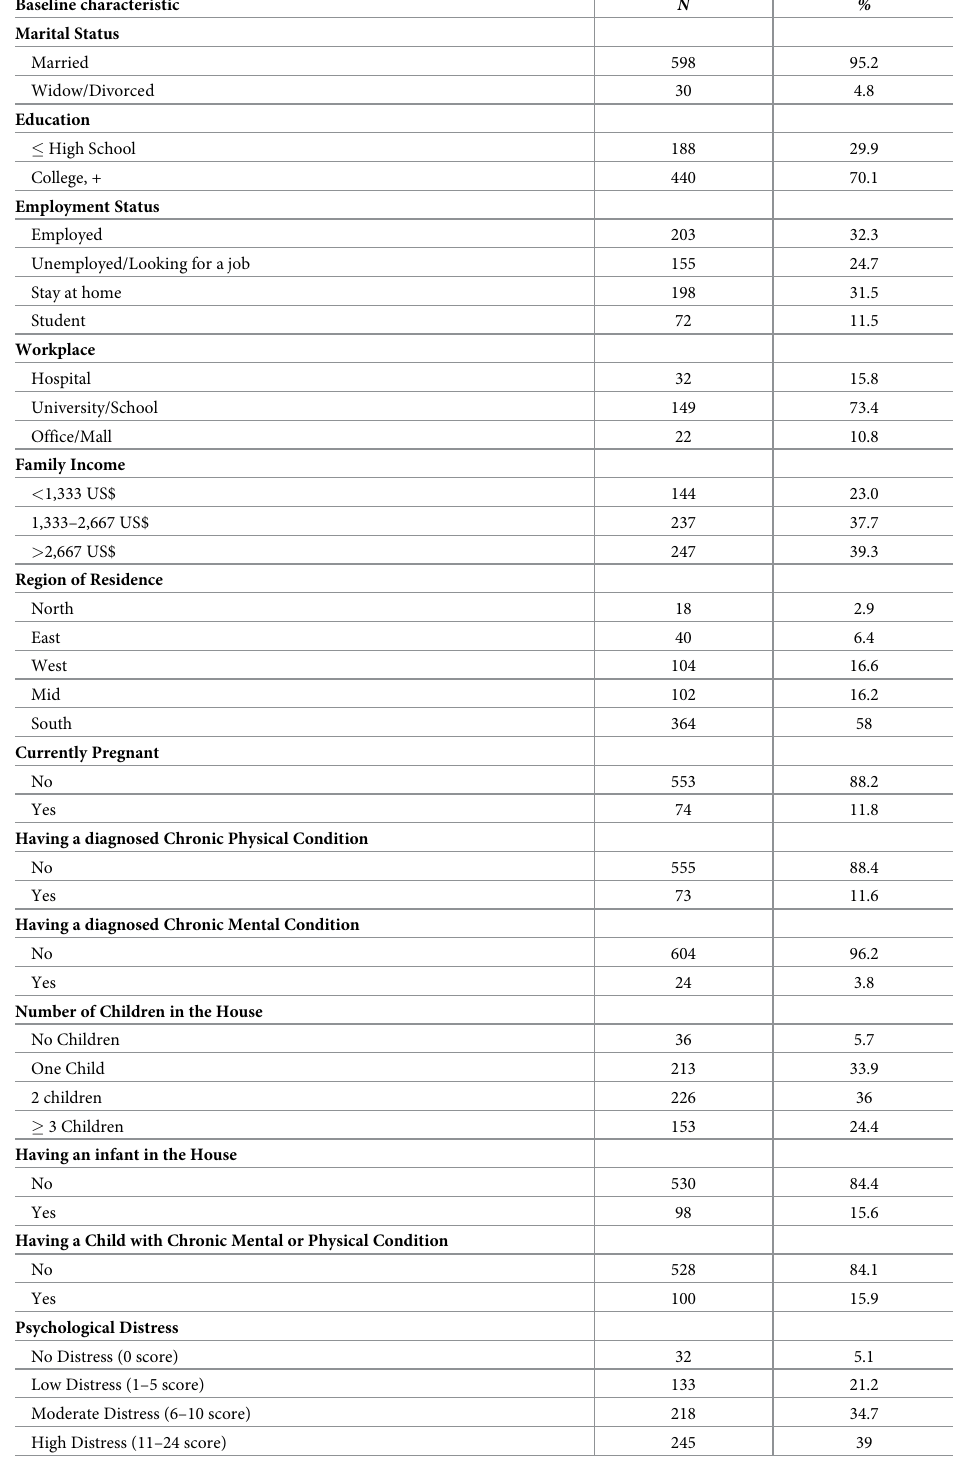
Table 1. Descriptive statistics of mothers and pregnant women in the study sample ( N = 628). Baseline